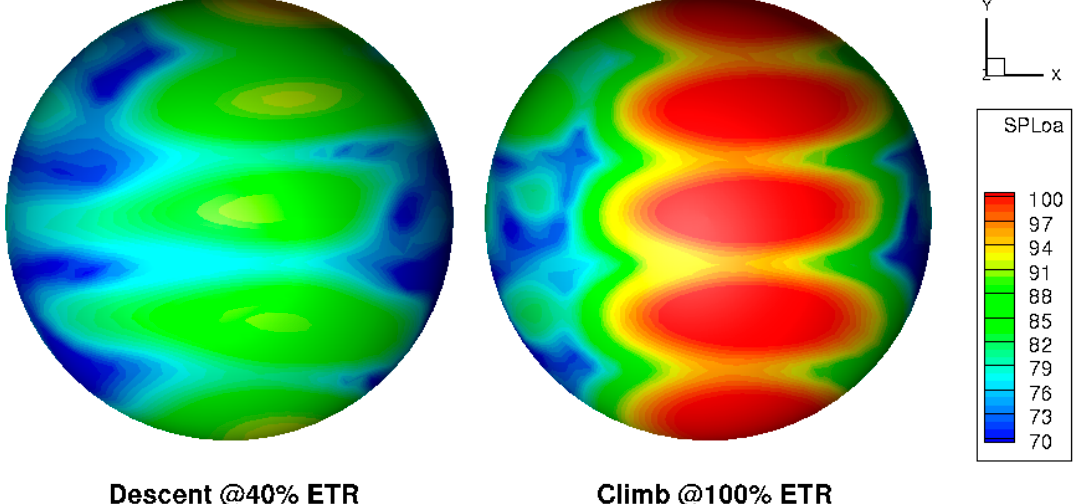
Figure 18. Configuration A, OASPL, in decibels, on the sphere, top view, in the two flight conditions analysed.